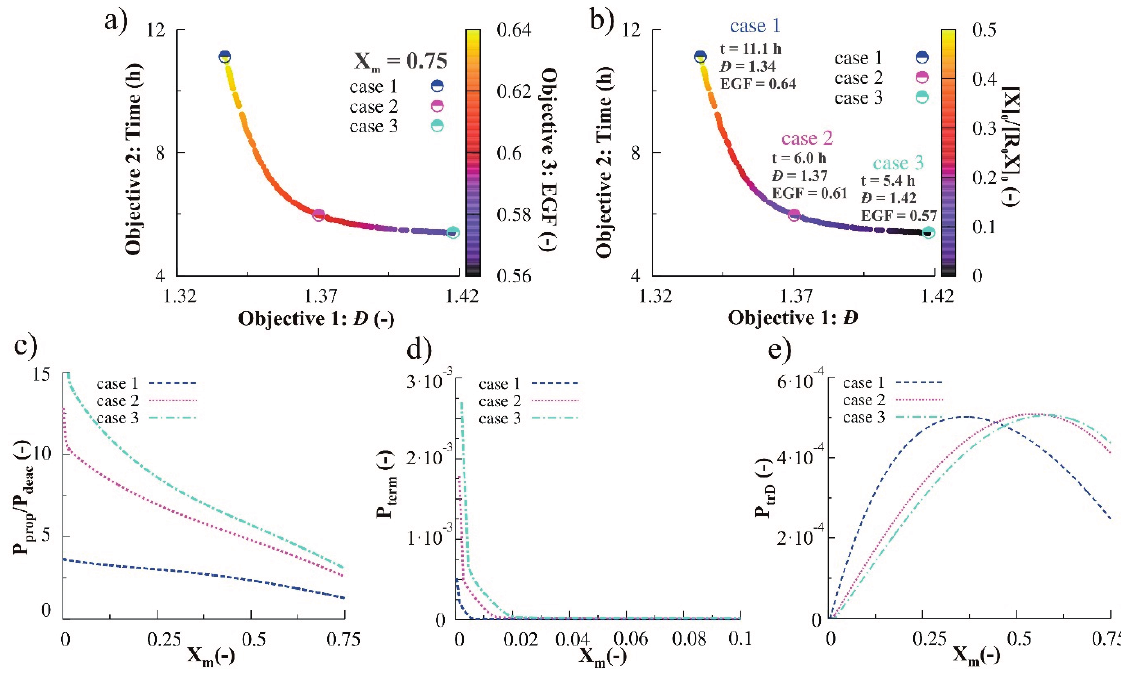
Figure 9. Results for the multi-objective optimization (MOO) of NMP of styrene (120 °C) using excess initial nitroxide ( Δ X m = 0.125 until X m = 0.75; ([ M ] 0 /[ R 0 X ] 0 = 1000/1). ( a ) Pareto-optimal front and corresponding isothermal front; ( b ) Variation of [ X ] 0 /[ R 0 X ] 0 along the Pareto-optimal front; ( c ) Ratio of probability for propagation to deactivation as a function of conversion for the selected cases; ( d ) Probability for termination as a function of X m for the selected cases; ( e ) Probability for chain transfer to dimer as a function of X m for the selected